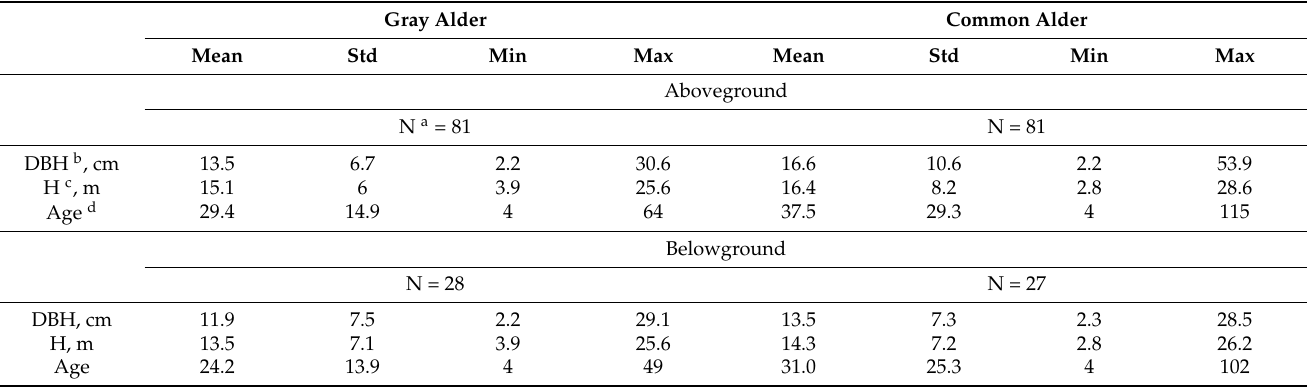
Table 1. Sample tree characteristics for aboveground and belowground investigations. Gray Alder Common